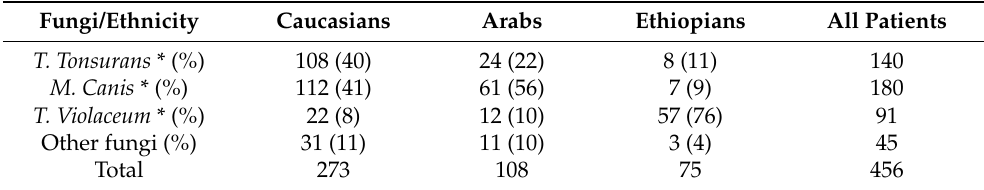
Table 3. Prevalence of main pathogens by